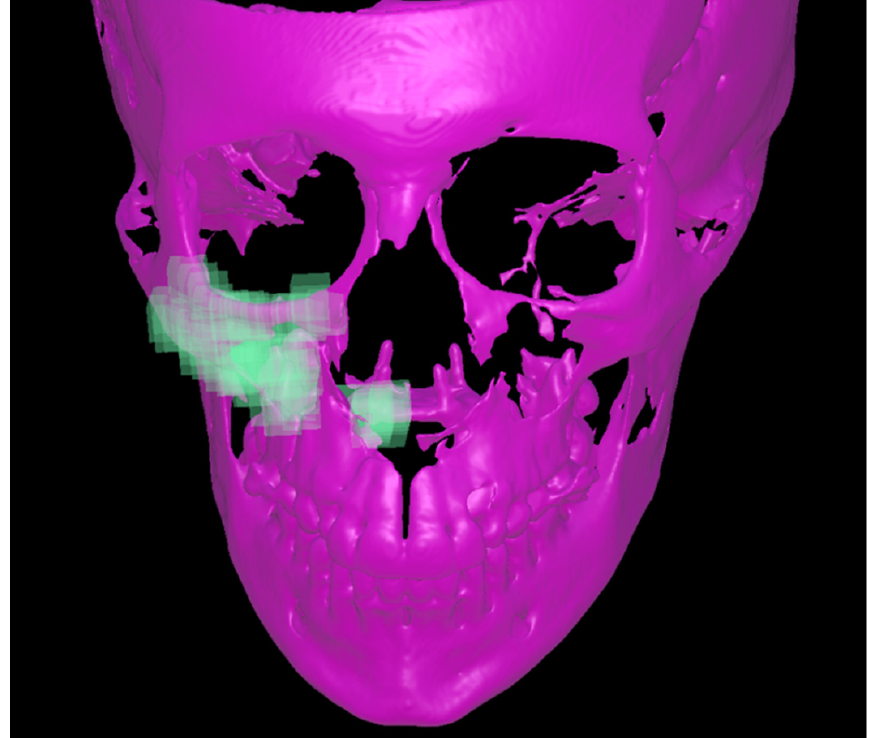
Figure 5. The registration of the pre- and post-expansion CBCT by using the zygomatic and palatal bone of each side as region of interest for superimposition (the green part). After this registration, bone and tooth surfaces were constructed using the marching cubes algorithm. To visualize the direction of the tooth movement with respect to